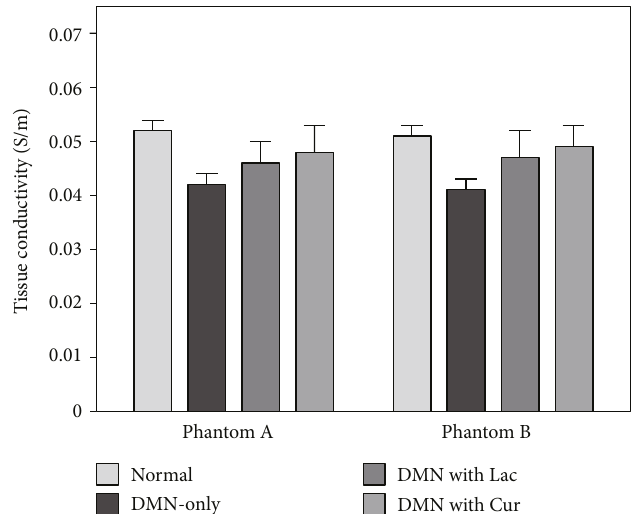
Figure 3: Bar graph showing quantitative analysis of conductivity contrast at four di ff erent experimental groups.